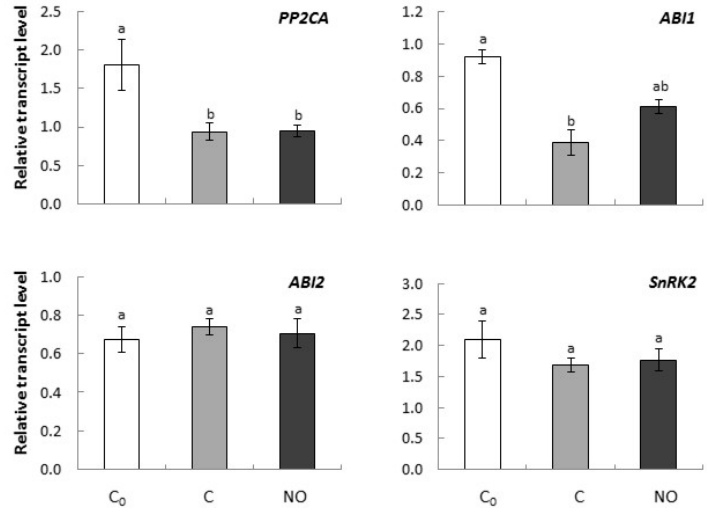
Figure 3. The relative expression level of genes encoding elements of ABA transduction pathway ( PP2CA , ABI1 , ABI2 and SnRK2 ) in axes of apple embryos isolated after 24 h of seeds imbibition in water (C 0 ), in axes of embryos imbibed in water for 3 h after seed coat removal (C), in axes of embryos fumigated with NO for 3 h (NO). The expression of genes was normalized to UBI as a reference gene. Two technical replicates were performed for each four biological replicates. Error bars represent ± SD; a, b homogenous groups.